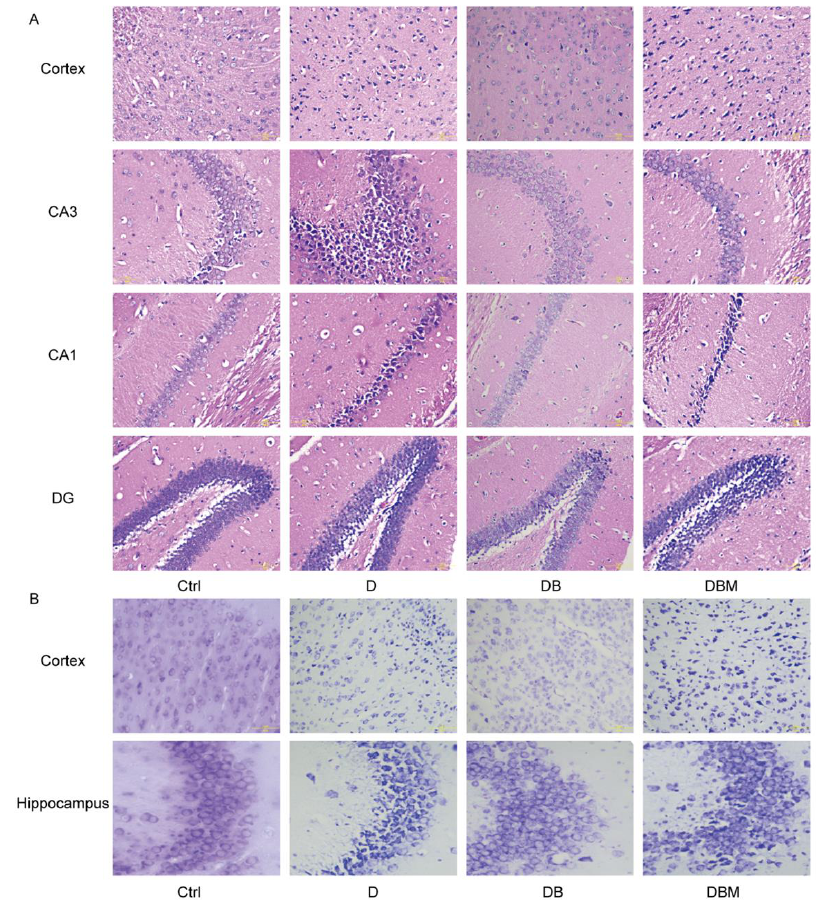
Figure 5. BBR rescued D-ribose-induced histological alterations. Histological sections of the cerebral cortex and the hippocampal stained with H & E and Nissl staining. Pictures showing the detail of H & E staining of the cerebral cortex and the hippocampal CA1, CA3 and DG neurons ( A ). Pictures showing the Nissl staining of the cerebral cortex and the hippocampal ( B ). Scale bar = 5 μm. Abbreviation: Ctrl, Control; D, D-ribose; DB, D-ribose + BBR; DBM, D-ribose + BBR + Mdivi-1. 2.4. BBR Ameliorates Cognitive Impairment of APP/PS1 Mice Induced by D-Ribose via Mi- tophagy